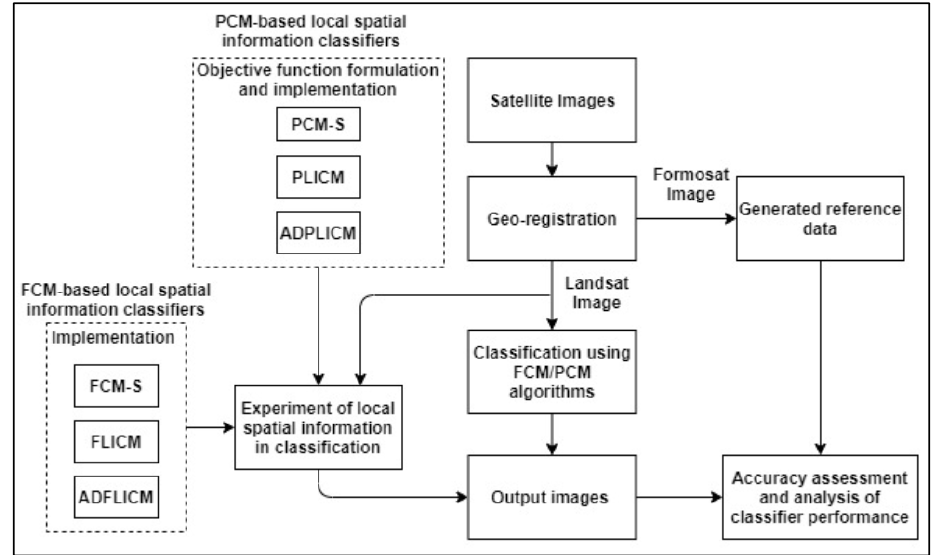
Figure 2. Steps for the adopted methodology in the